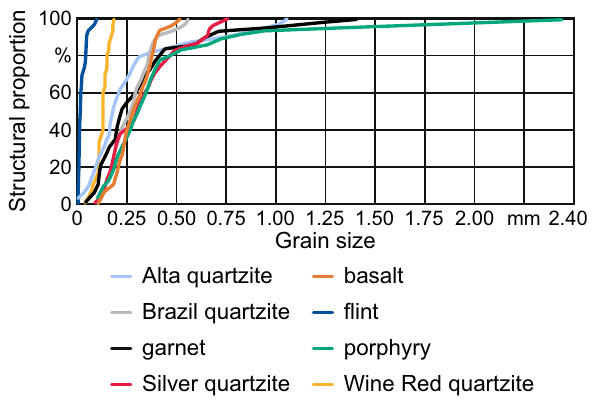
Fig. 2 Proportion of rock grains of different grain sizes in the micro- structure